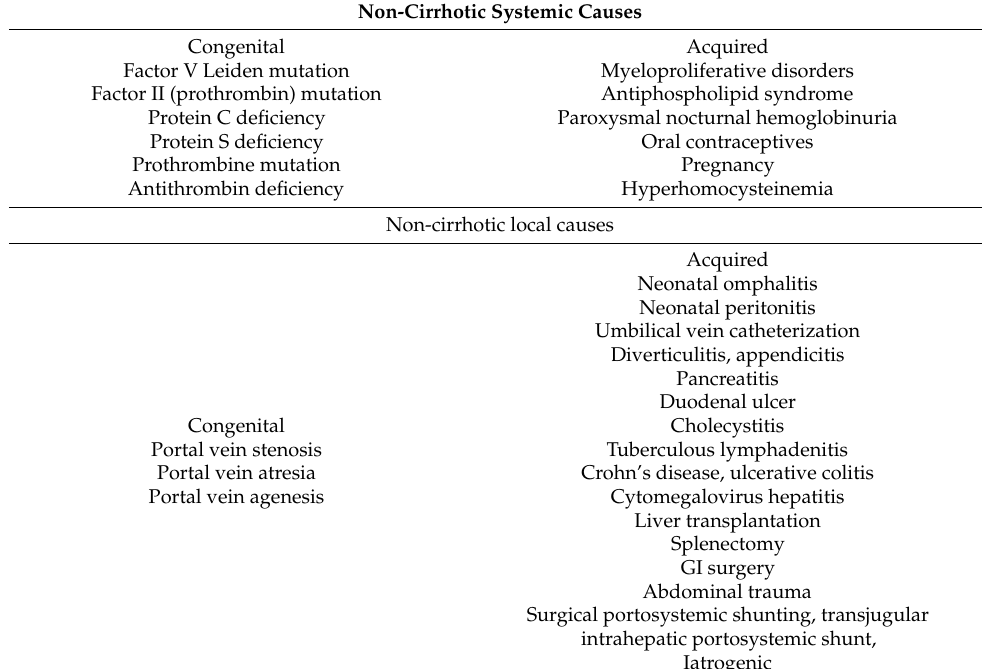
Table 1. Etiopathogenesis of non-malignant portal vein